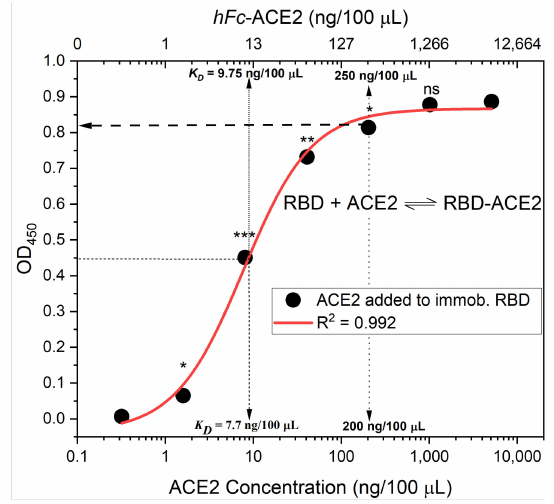
Figure 2. The binding affinity of ACE2 added to immobilized RBD. RBD (50 ng/100 µ L per well) was immobilized on ELISA plates, then ACE2 solutions with various concentrations were added to the immobilized RBD. Bound ACE2 and saturation were determined from the OD 450 signal and fitted to a four-parameter logistic function, providing an R 2 = 0.99 and a binding affinity dissociation constant of K D = 10 ng/100 µ L, as determined at 50% of the maximum signal reading. The highest reading that resulted in significant OD increase corresponded to 250 ng/100 µ L of hFc -ACE2. Therefore, a 5:1 concentration ratio of hFc -ACE2 to RBD (or 200 ng/100 µ L, 4:1 ratio of ACE2/biotinylated- ACE2) is required for saturation with a statistically significant maximum OD signal ( p < 0.05). This corresponds to an equimolar ratio between the two proteins that achieves a 1:1 binding ratio. Asterisks represent the statistical significance level of each data point (compared to the preceding data point) using the student t -test, * p ≤ 0.05; ** p < 0.01; *** p < 0.001; ns is non-significant, p >